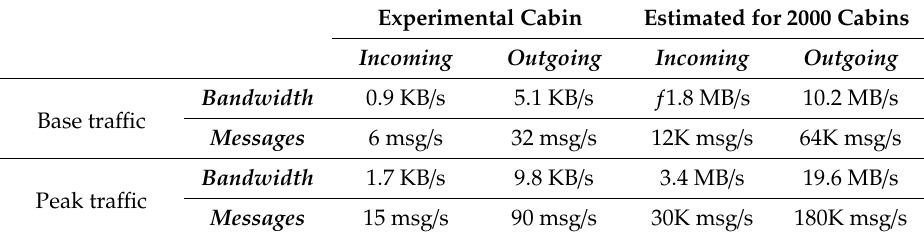
Table 1. Statistics about the traffic in the real and in the estimated scenario.